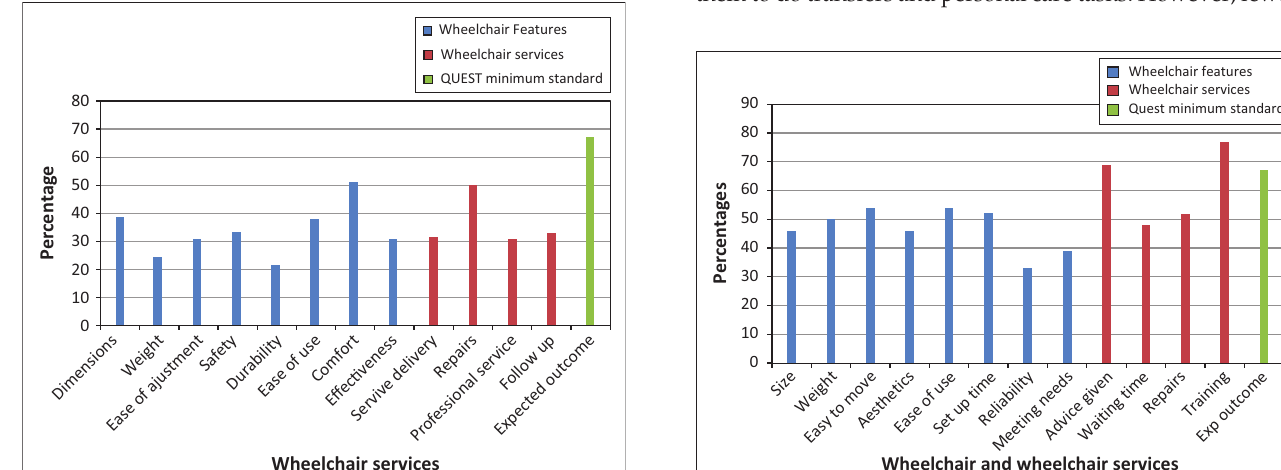
Wheelchair and wheelchair services FIGURE 4: Percentage of child users who were very or quite satisfied with their wheelchair and wheelchair services according to the children’s QUEST 2.1 ( n =